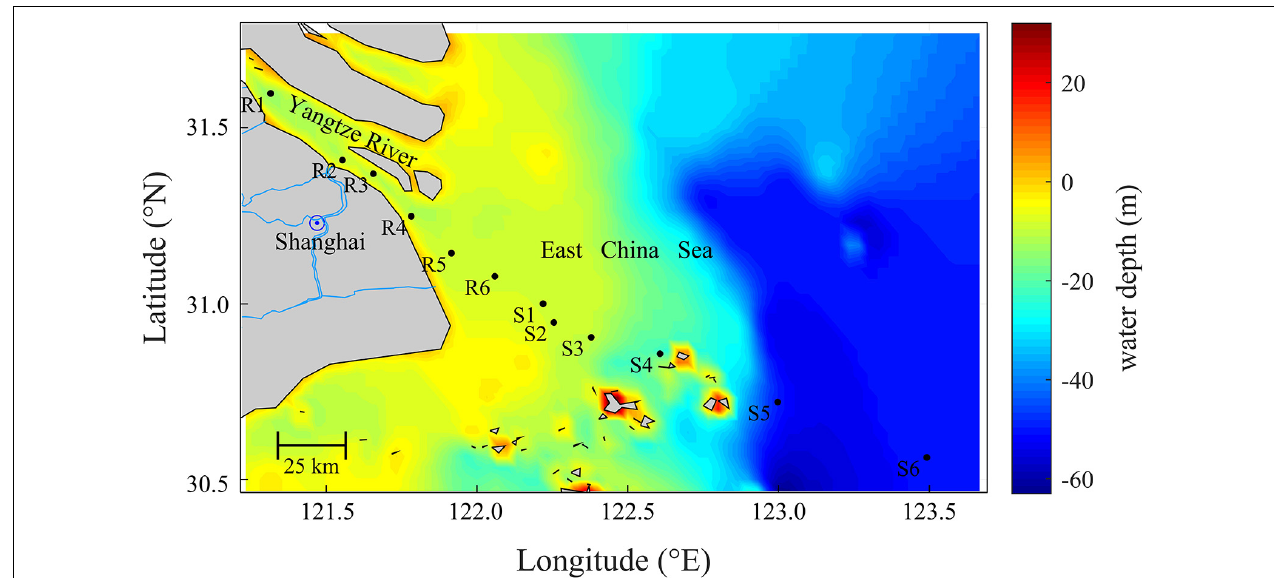
FIGURE 1 | Map showing sampling sites along the transect of lower Yangtze River to East China